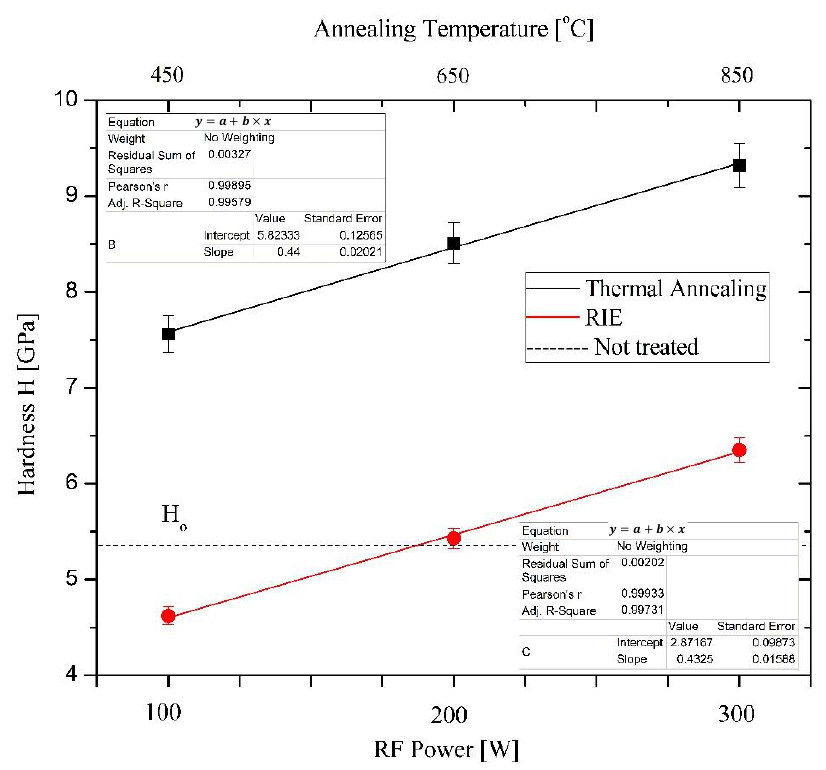
Figure 2. Hardness plots of the annealed samples in an N 2 atmosphere at different temperatures and for RIE process treated in an Ar-N 2 gas mixture for 10 min by different RF power. Round circles — RIE-treated; squares — temperature-treated.